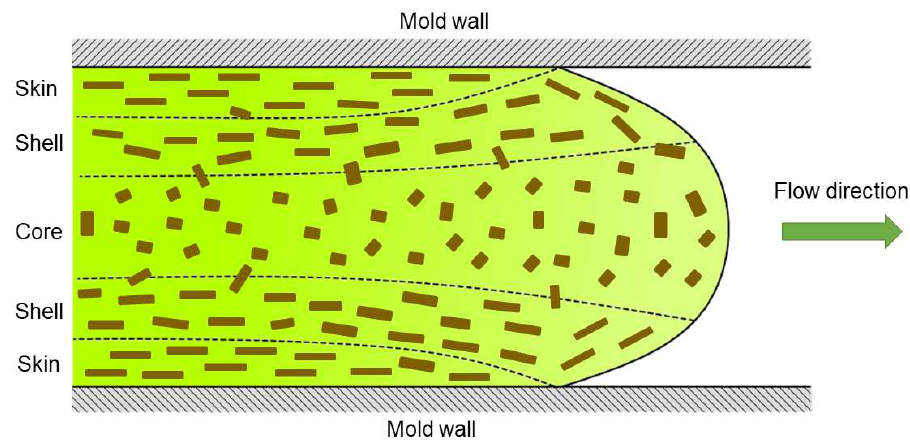
Figure 5. Orientation of reinforcement fibers across the matrix during injection molding.